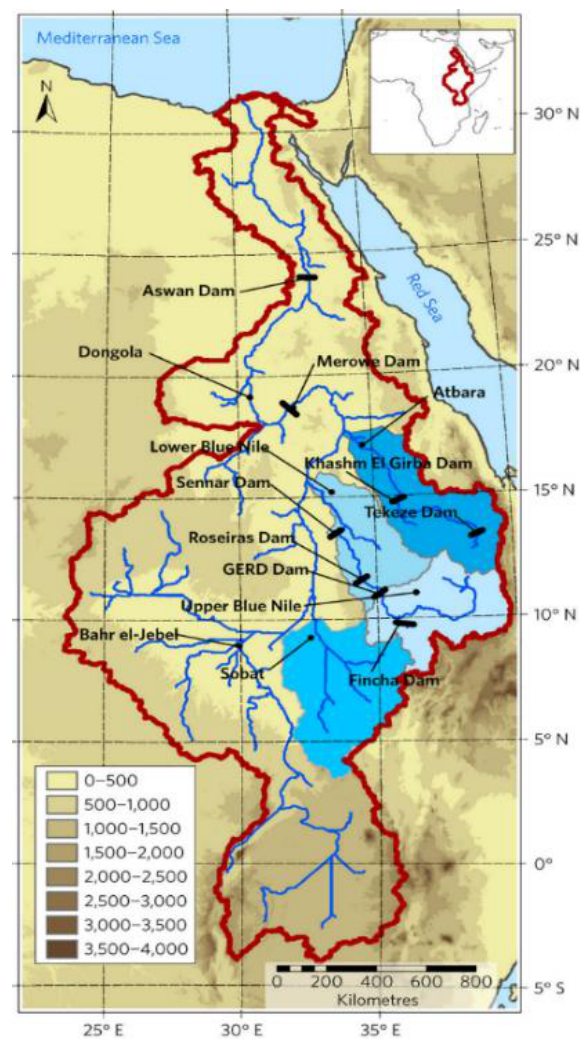
Figure 4. Map of the Nile Basin that identifies the location of some of the critical dams. The map includes the old dams such as the Aswan dam and also new dams such as the Grand Ethiopian Renaissance Dam (GERD), which is still under construction. Source: Siam (2017), [53]. According to Whittington (2014), the GERD may lead to improved upstream Blue Nile regulation, resulting in increased energy production by the Sudan dams (Merowe, Sennar, and